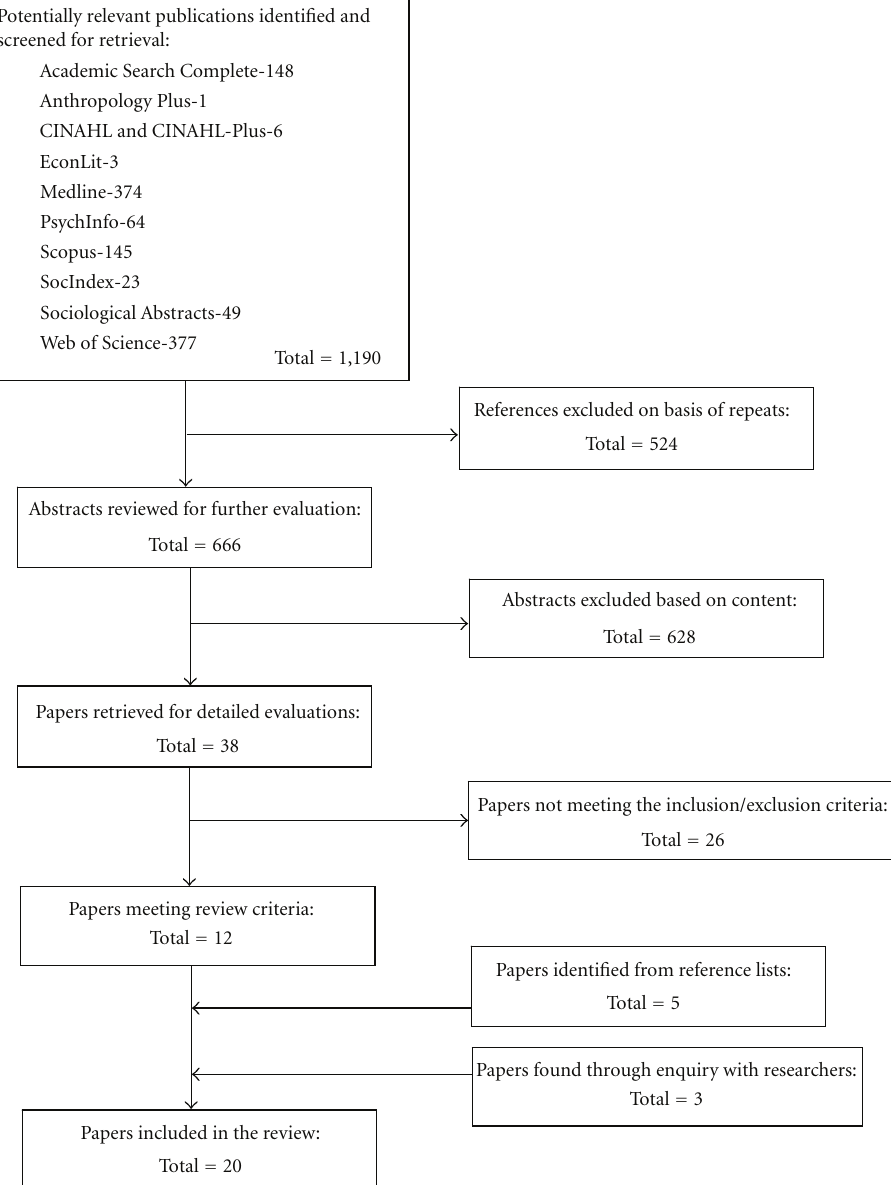
Figure 1: Flow chart of the search